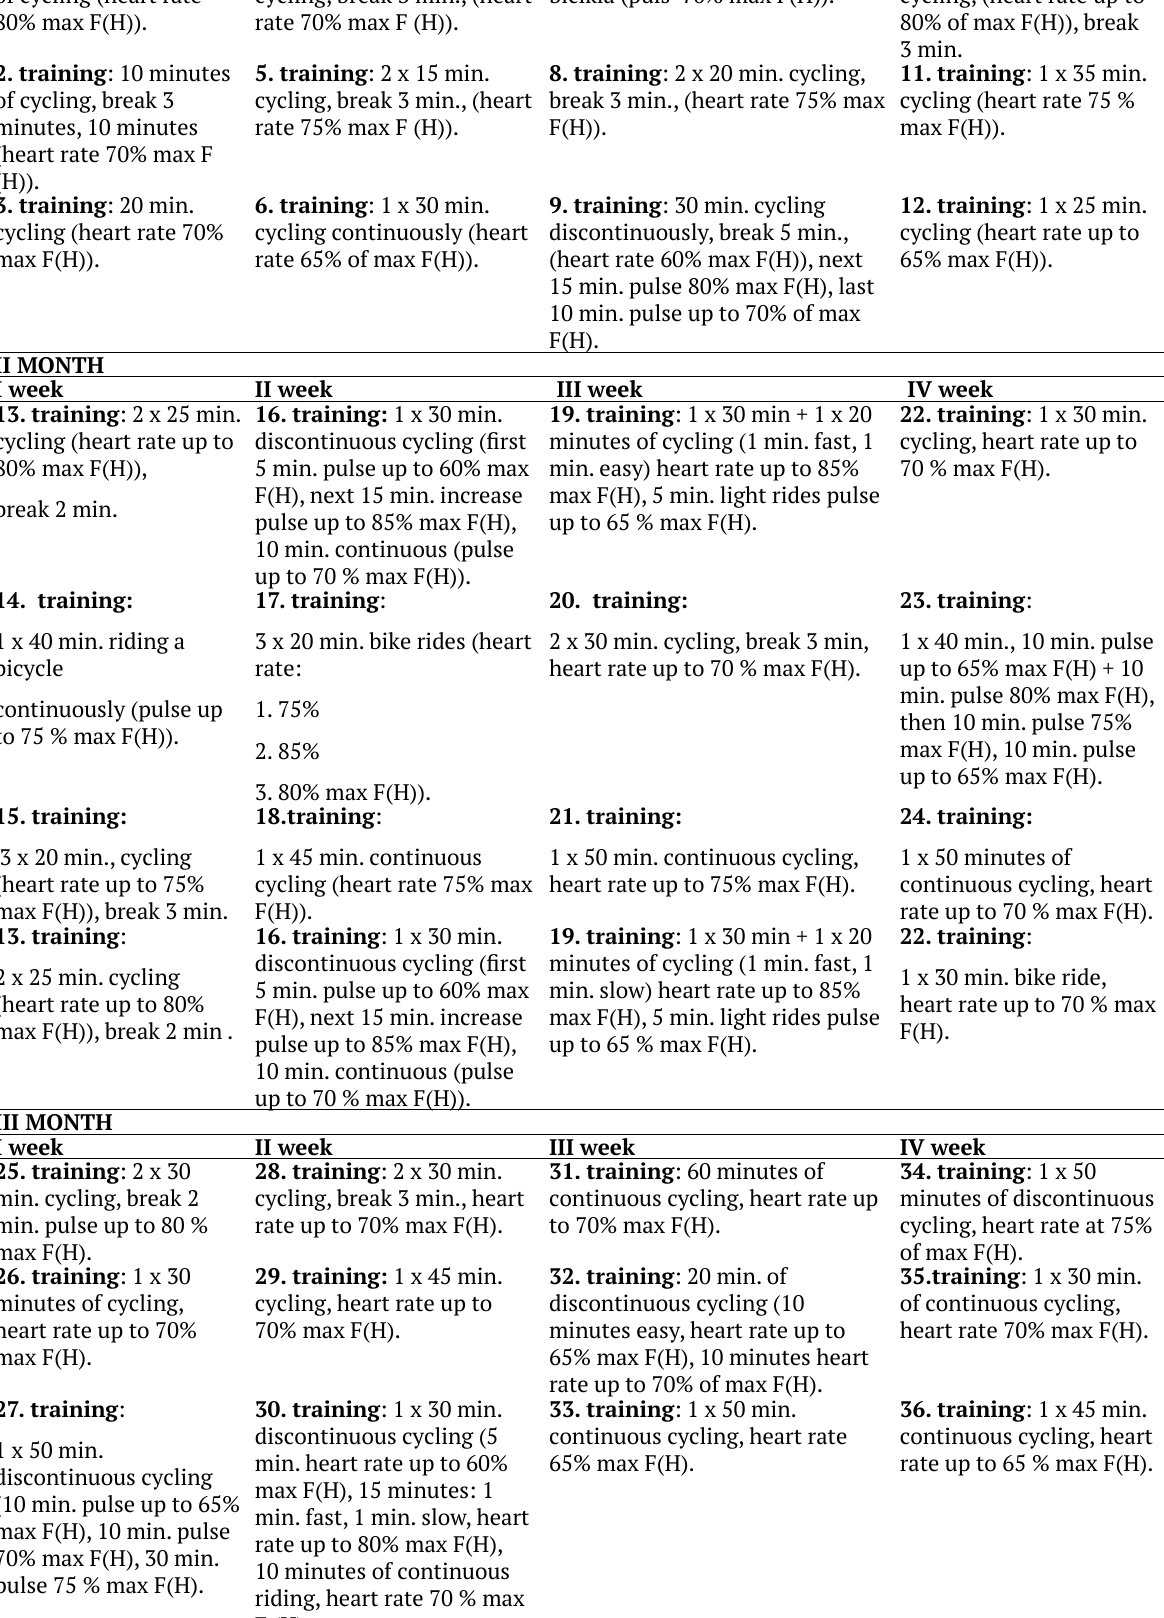
Table 1. Experimental cardio program (three-month duration) I MONTH I week II week III week IV week 4. training : 3 x 10 min. 1. training : 15 minutes cycling, break 3 min., of cycling (heart rate 80% max F(H)).